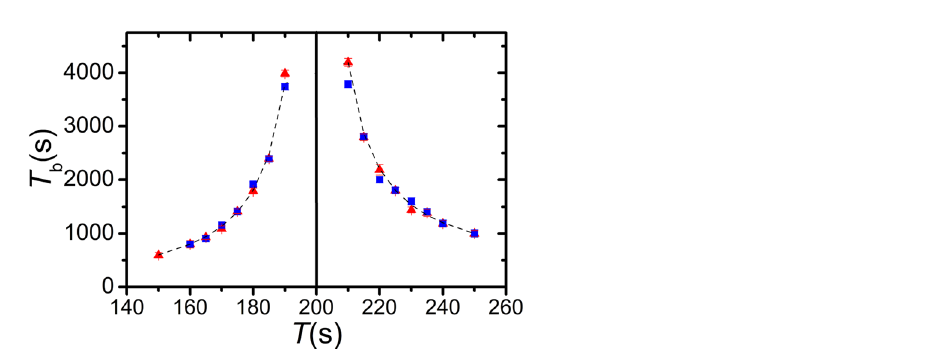
Figure 2. Beat phenomenon in the acid–base neutralization reaction using sinusoidal time-dependent inflow rate functions of the reagents, acid solutions with ϕ = π, r 0 and r A were 15 µL s −1 . The time period of the inflow rate of the acid was fixed, T acid = 200 s , and in each experiment T base was varied. The concentrations of the acid and alkaline solutions in